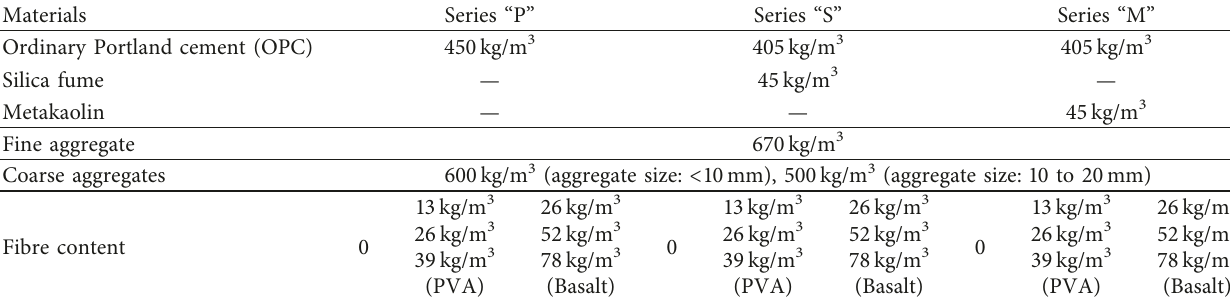
Table 1: Material and mixture composition used in the experimental